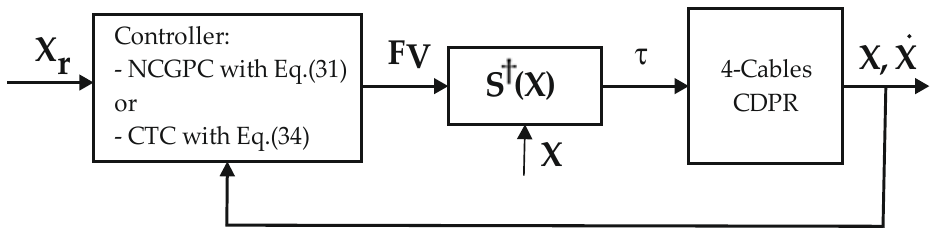
Figure 3. Proposed control schemes for the proposed planar 4-cable CDPR.